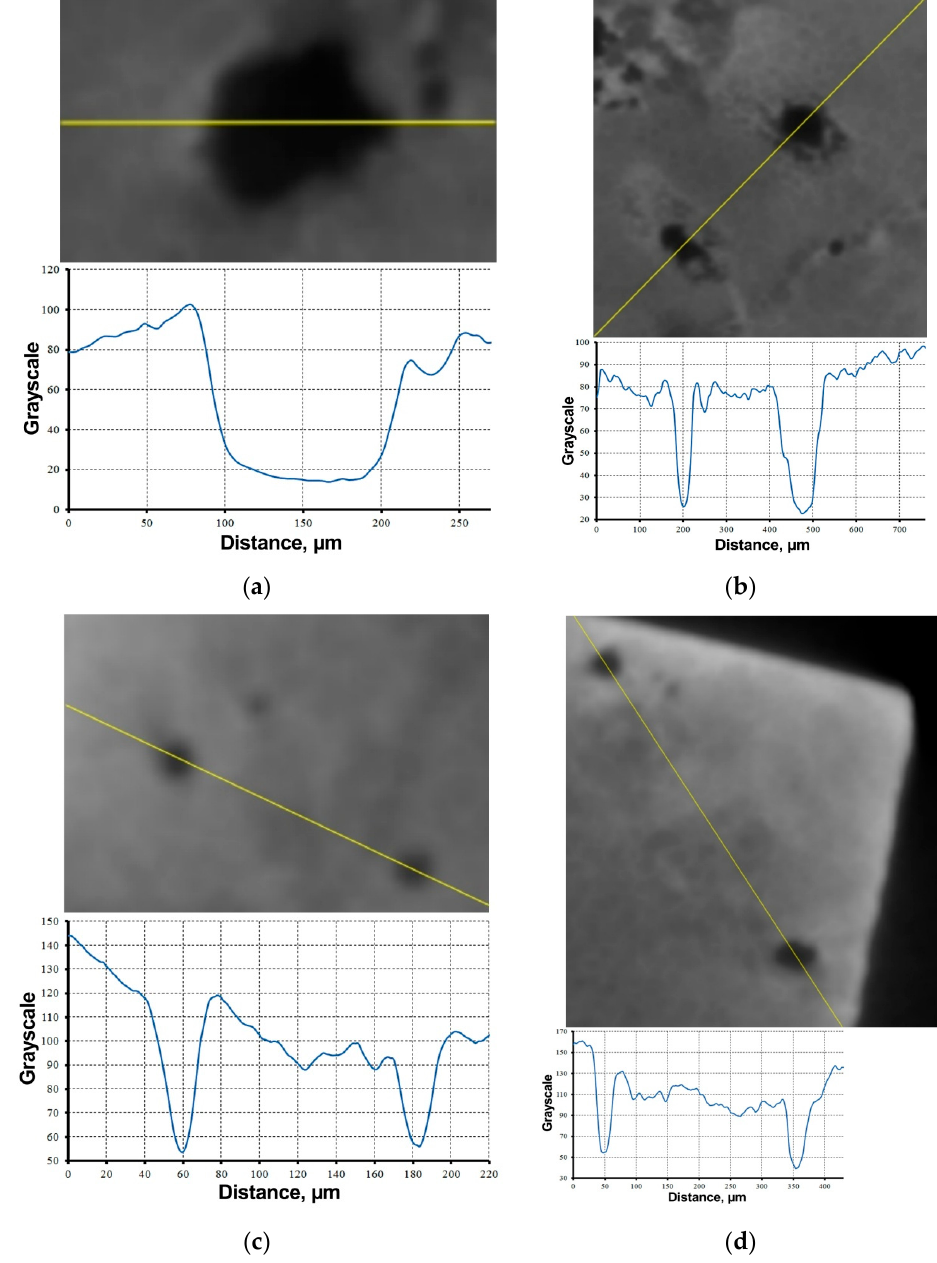
Figure 8. Pores in the TiNi–TiB 2 metal–matrix composite obtained by direct laser deposition, and a graphical representation of the change in grayscale values along the cutting plane line in the plane of the pore location—inside pores ( a – c ), surface pores ( d ).